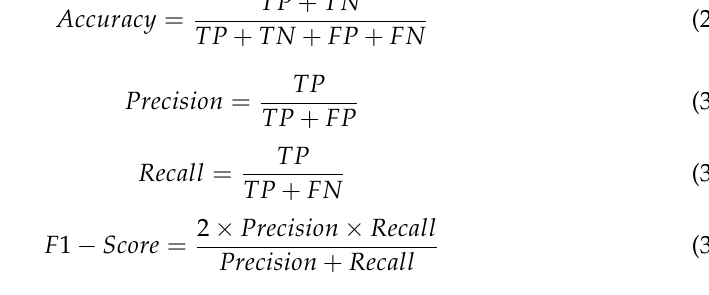
Table 1. Summary of the performance metrics. Class N (Truth) N